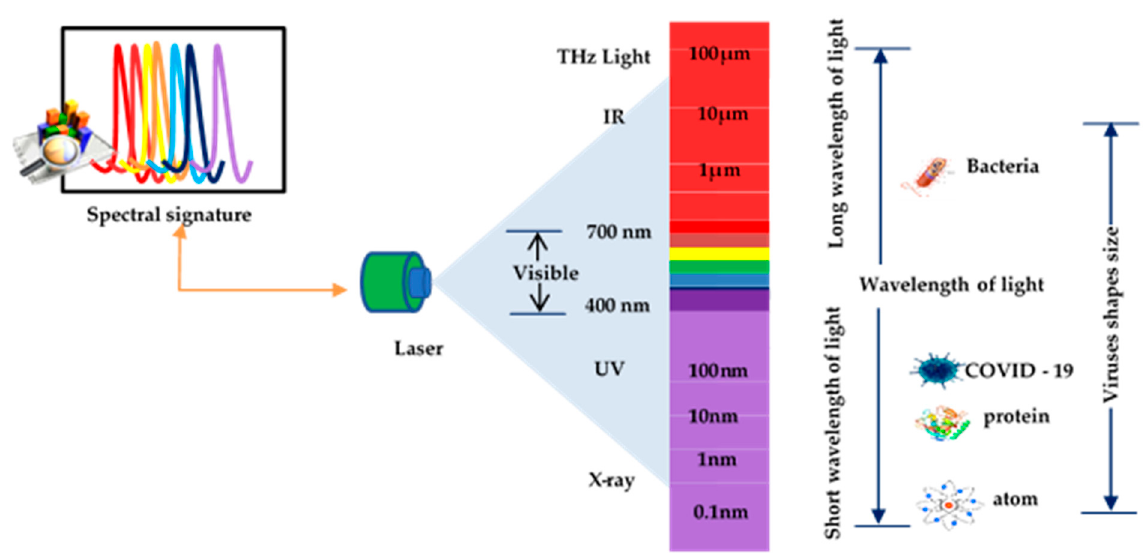
Figure 2. Comparison of the size of viruses for selecting a wavelength suitable to be used to diagnose COVID-19.